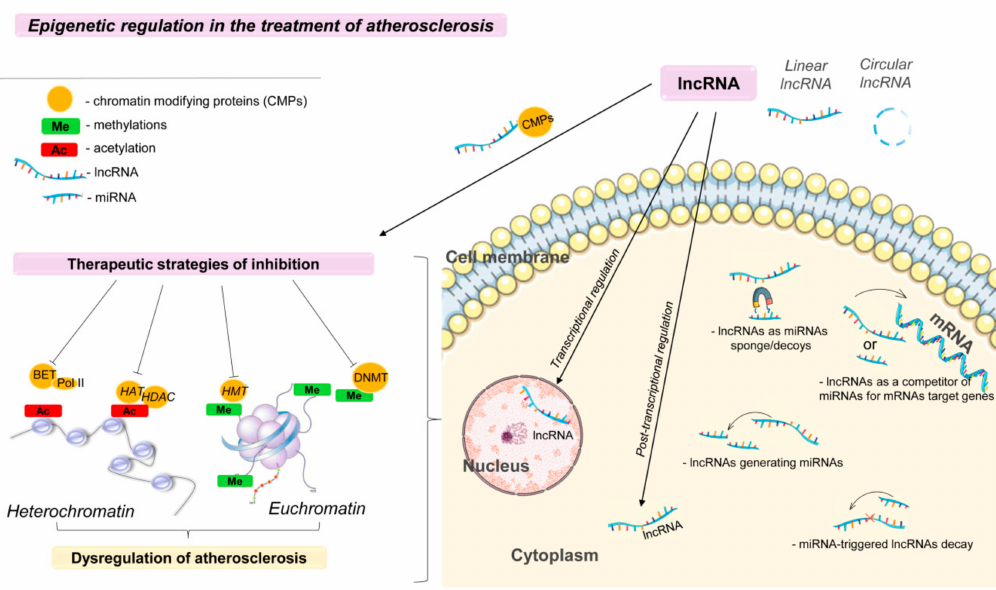
Figure 2. Epigenetic regulation in the treatment of atherosclerosis. Ac—acetylation; Bet—bromodomain and extraterminal protein; Pol II—Polymerase II; HMT—histone methyltransferases; HDAC—histone deacetylase; DNMT:—DNA methyltransferase; HATs—histone acetyltransferases. This figure has